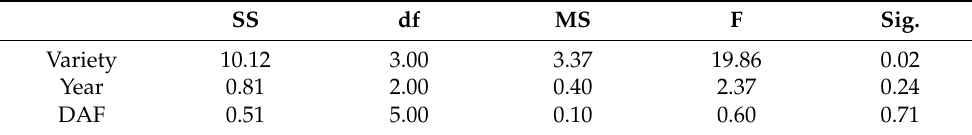
Table 5. The result of analyses of variance (ANOVA) of threshing force. SS—Sum of squares, df—degree of freedom, MS—mean squares, F ratio, and Sig.— p -value.